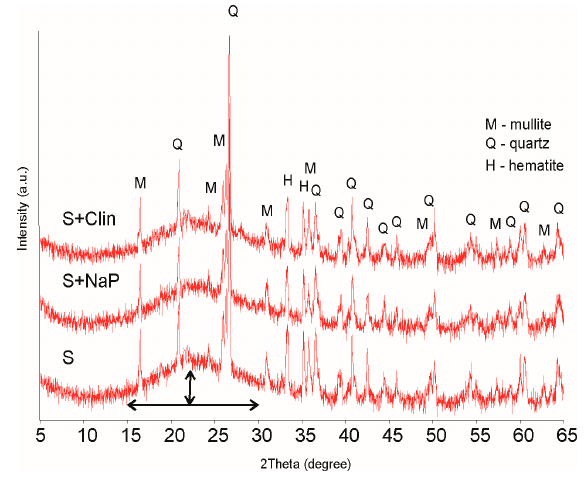
Figure 1. X-ray diffraction (XRD) patterns of the control aggregates.